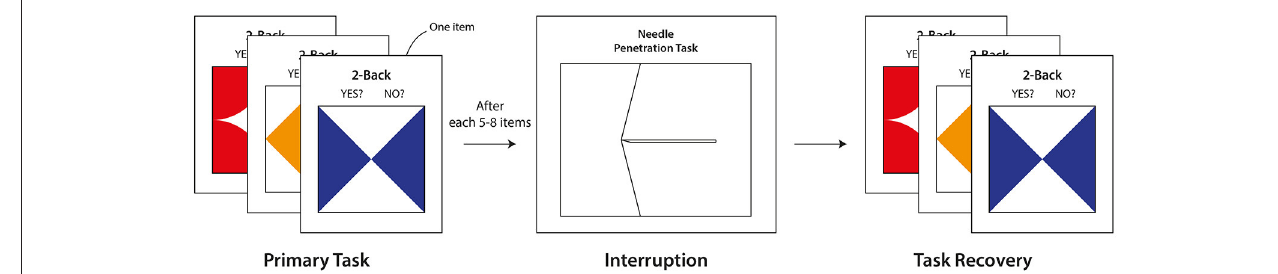
FIGURE 1 | Visuo-tactile two-back task interrupted by virtual needle penetration task.